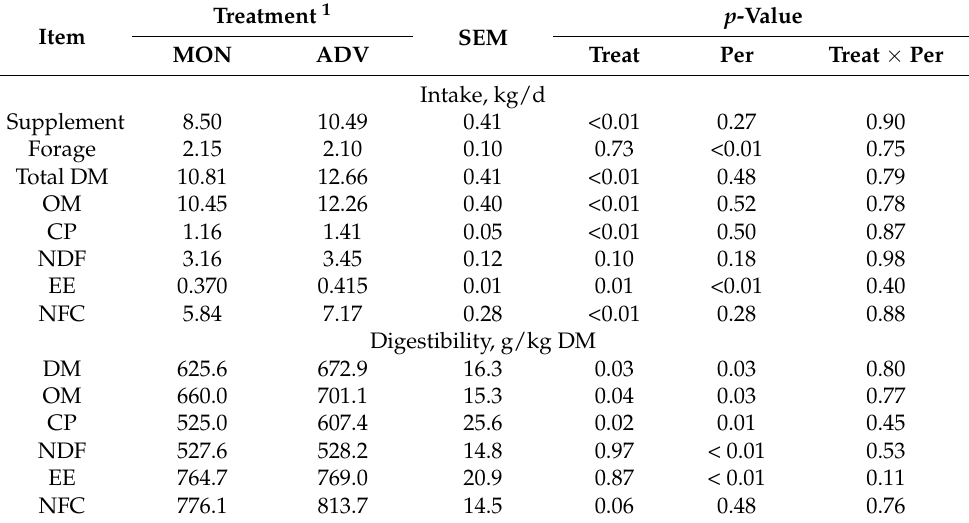
Table 3. Intake and digestibility of Nellore bulls finished on pasture with high concentrate supple- mentation, with monensin (MON) or a blend of live yeast and organic minerals (ADV).